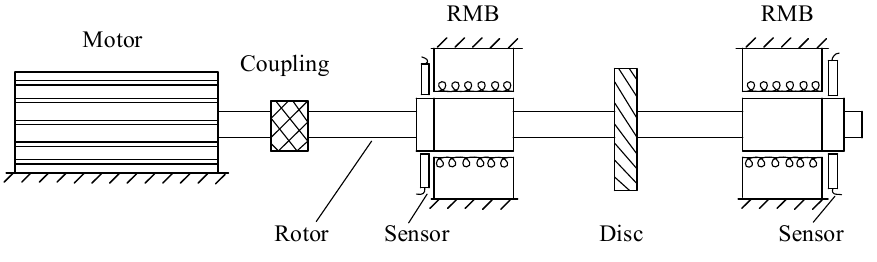
Figure 2. RMB device platform.